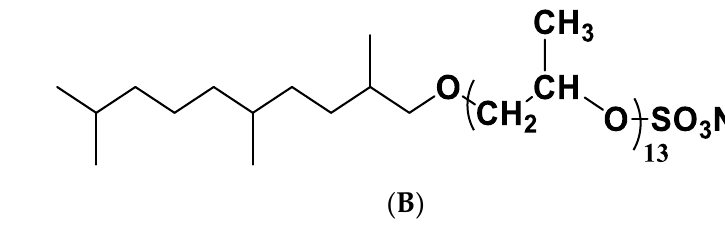
Figure 10. Structural formula of ASB ( A ) and A145 ( B ).